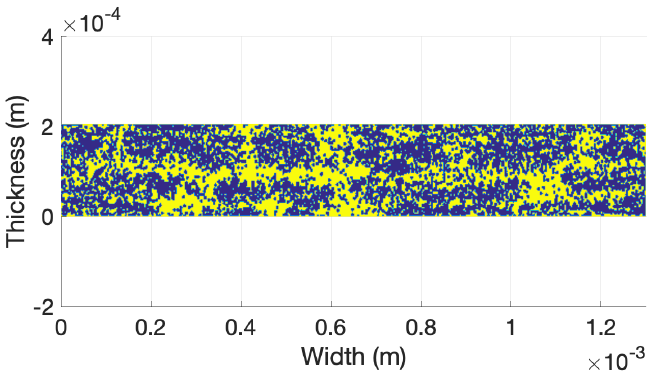
Figure 1. Composite material cross section, obtained by using micro-tomography on a composite tape. In blue are the fibers and in yellow is the